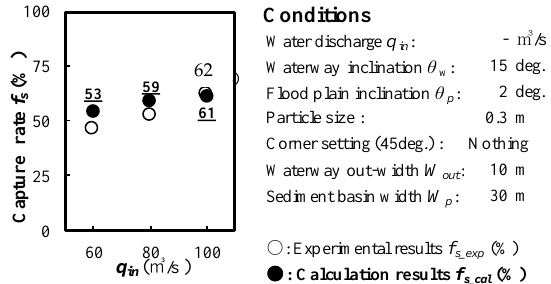
Figure 22. Comparison of the experimental results and numerical analysis results for changes in the downstream opening width of the sediment retarding basin.